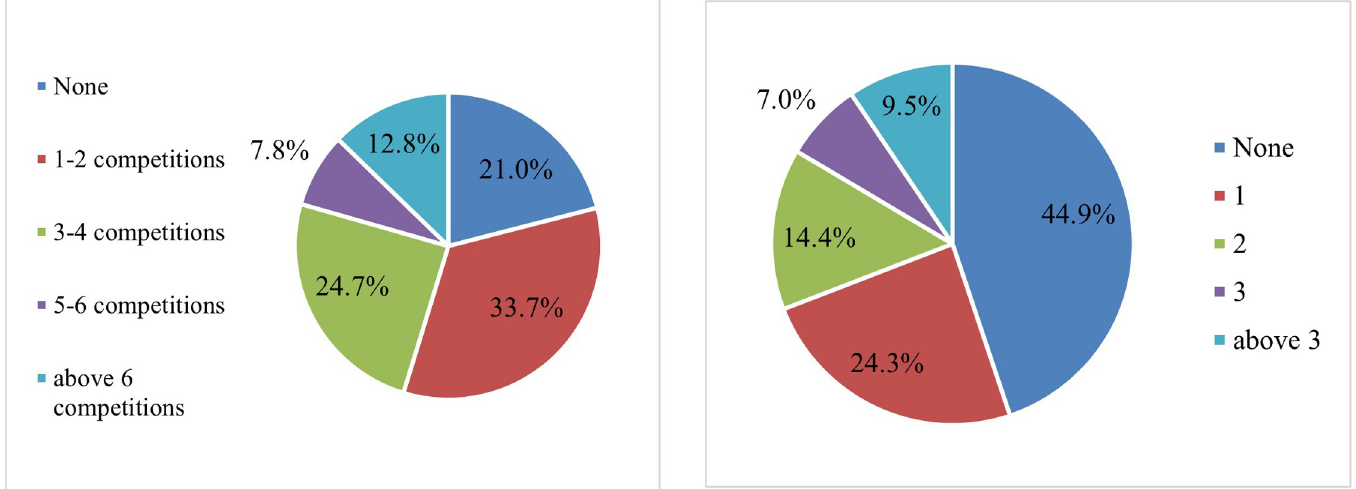
Fig 4. Number of competitions in which respondents participated in the last 5 years and number of applications that obtained funding. Source: authors own calculations.